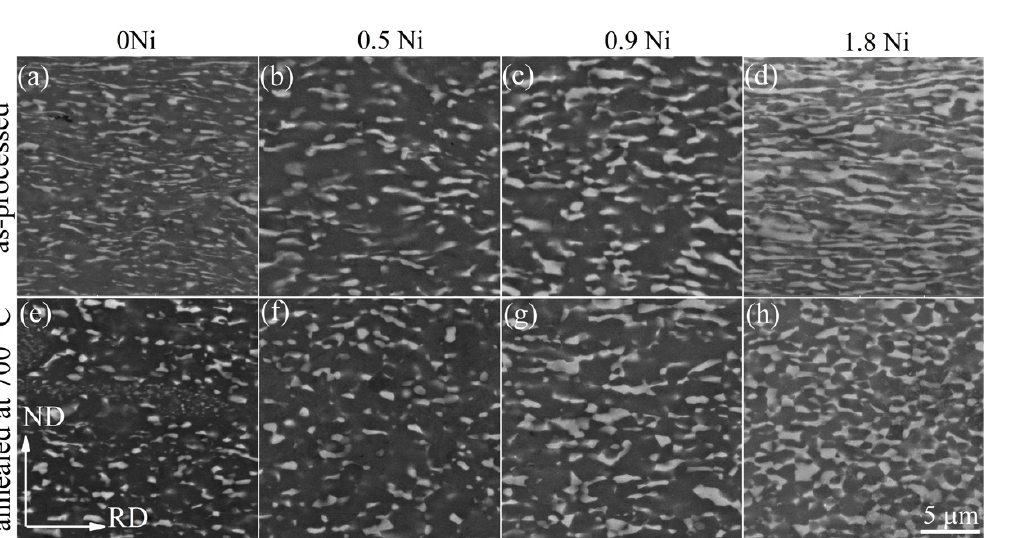
Figure 1. ( a , b ) Polythermal sections of the Ti-4Al-3Mo-1V-0.1B-xNi phase diagram constructed by Thermo-Calc software, ( c ) DTA spectra, and ( d ) XRD patterns for the investigated alloys. 3.2. Analysis of the Microstructure after Sheet Processing and Annealing The α and β phases were elongated to the rolling direction after the thermomechanical treatment (Figure 2a–d).